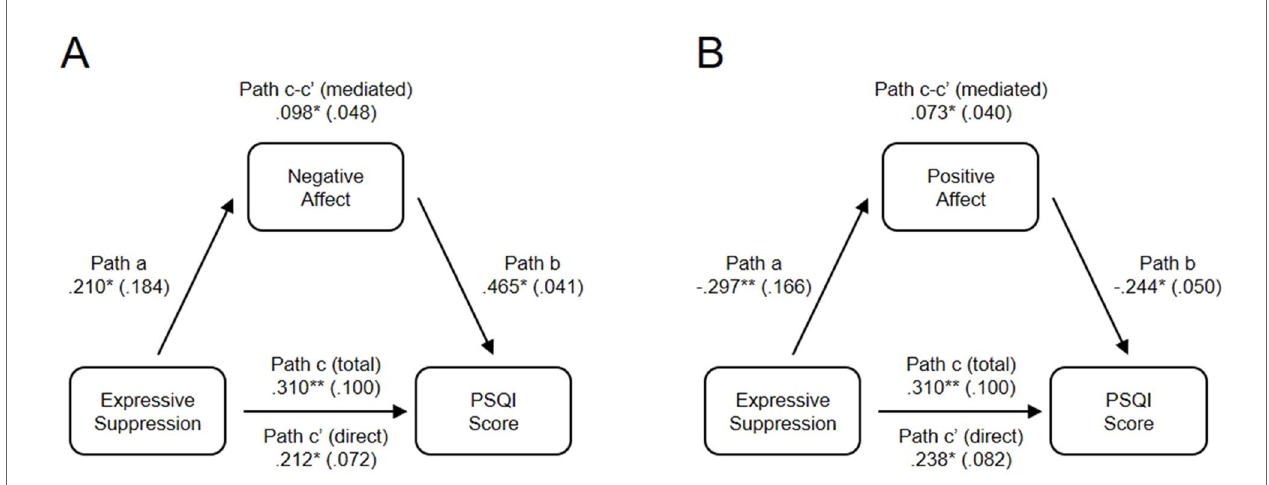
FIGURE 1 | Partial mediation between expressive suppression and sleep quality by both (A) negative affect, and (B) positive affect. Data values are regression betas for specific pathways, with standard errors shown in parentheses. High PSQI scores indicate poor sleep. * p < .05, ** p <